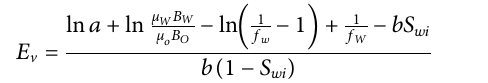
FIGURE 7 | The comparison of theoretical relative permeability curves and experiment relative permeability